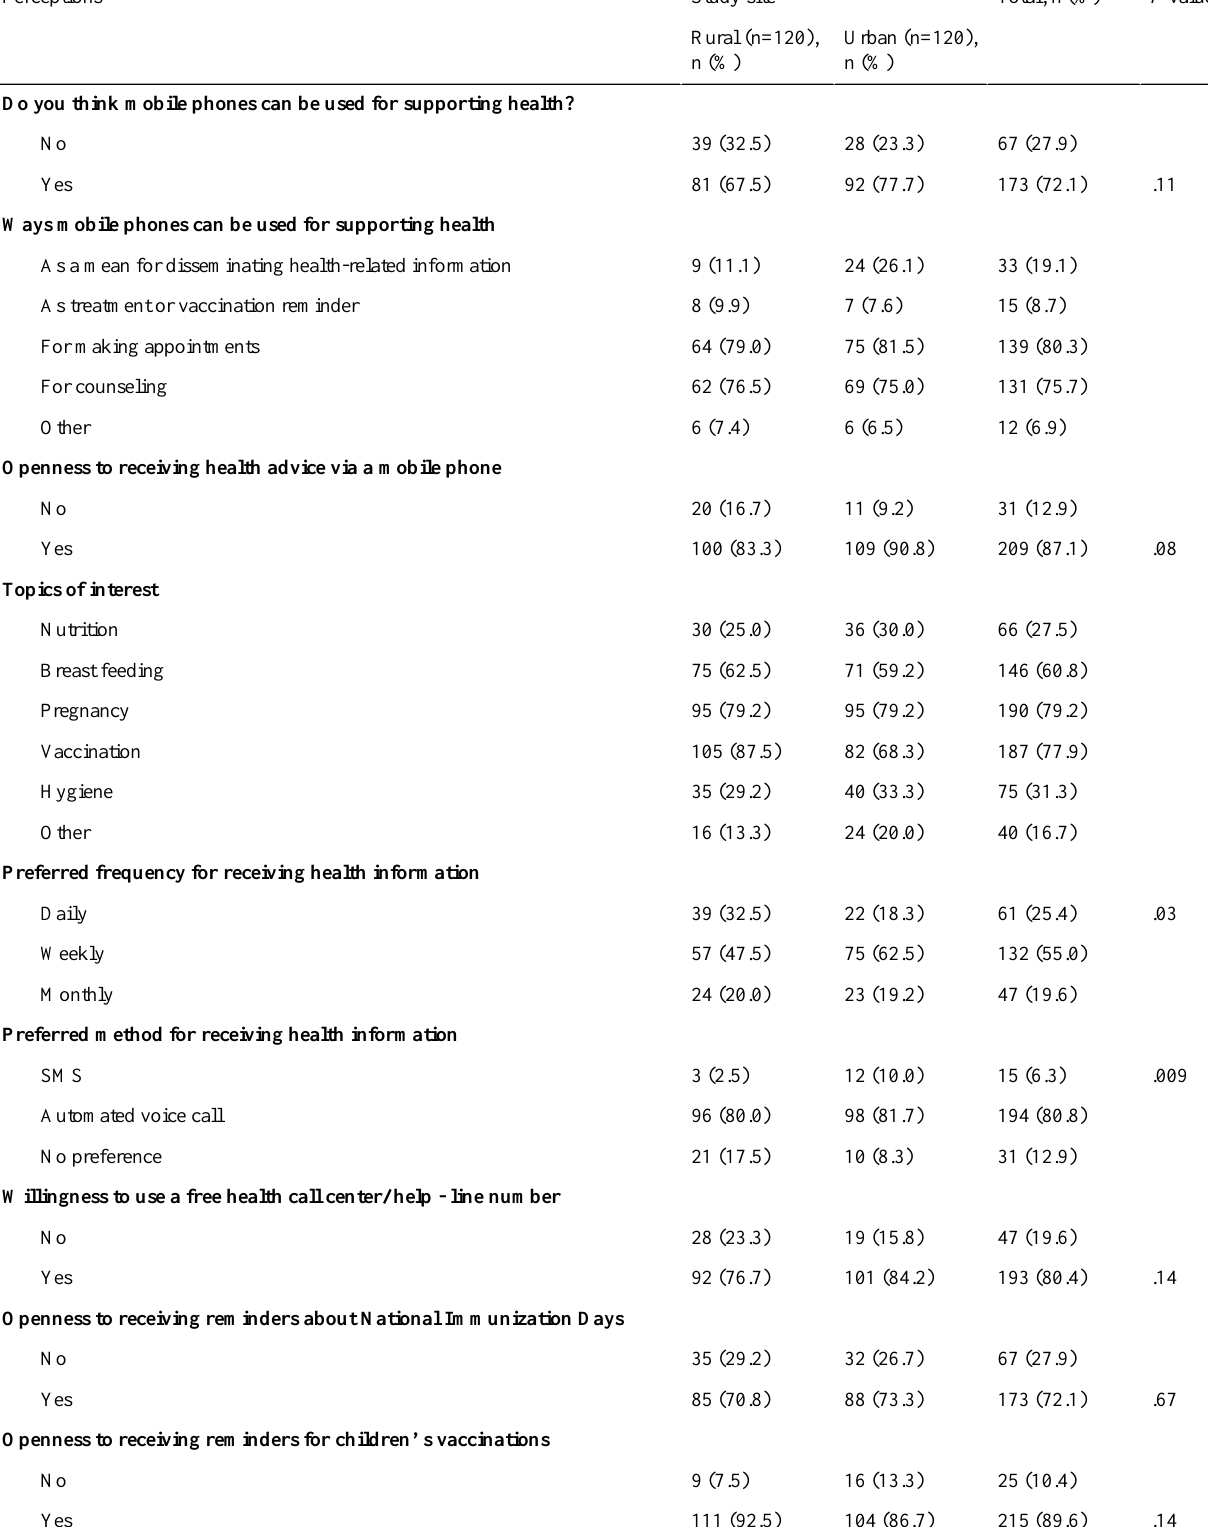
P valueTotal, n (%)Study